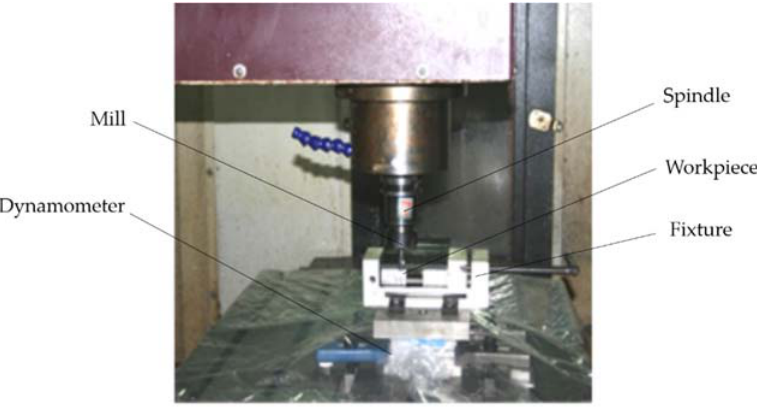
Figure 7. Experimental setup.